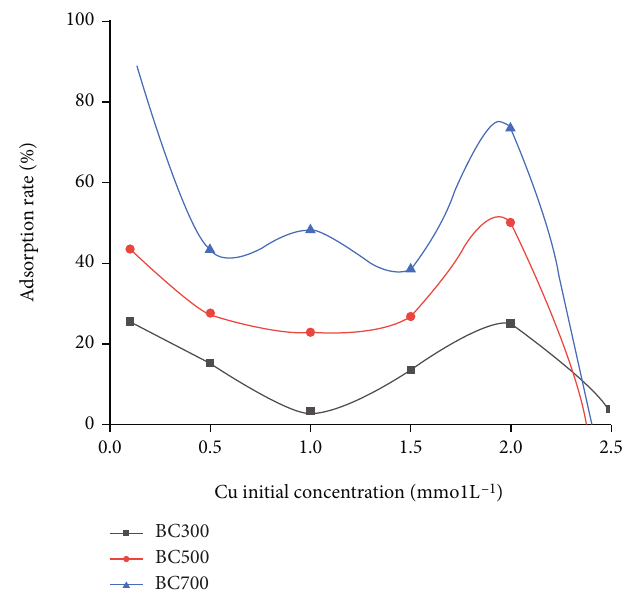
Figure 9: Adsorption rate of Pb 2+ in straw with di ff erent concentrations of heavy metal